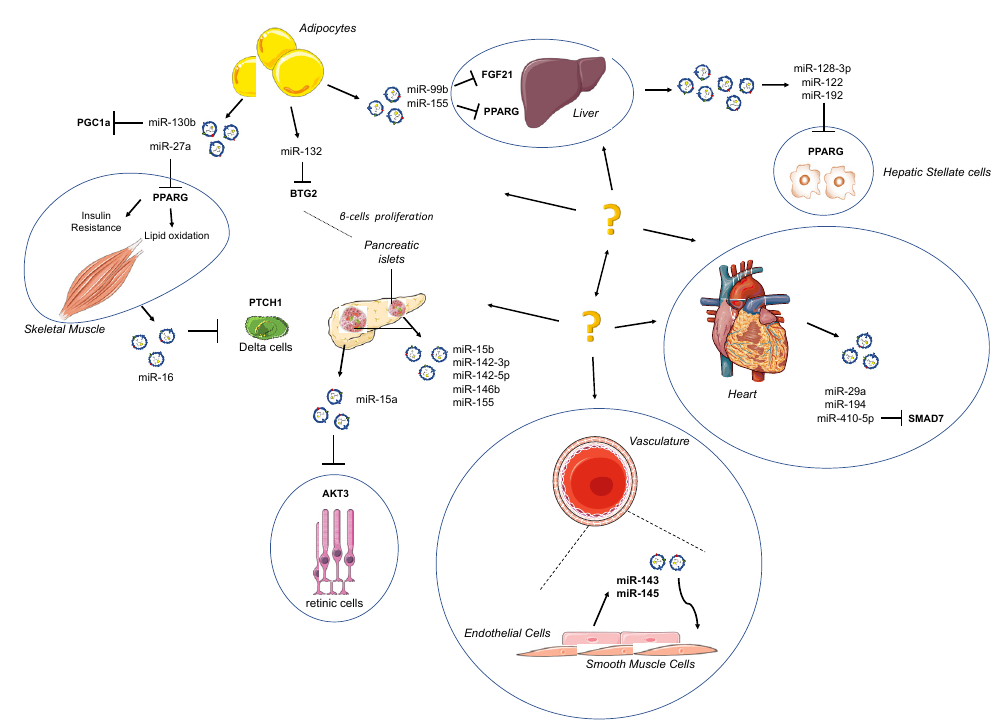
Figure 1. Schematic depiction of exo-miRs released by surrounding organs. Adipose tissue (AT) acts as an active endocrine and energy-supply organ. It has emerged as a source of extracellular microRNAs (miRNAs), exerting a paracrine communication between the liver, skeletal muscle, pancreas and cardiovascular system. The strong connection among organs may be attractive targets for novel therapeutic strategies. Table 1. Mammalian miRNAs regulating adipogenesis and insulin sensitivity.